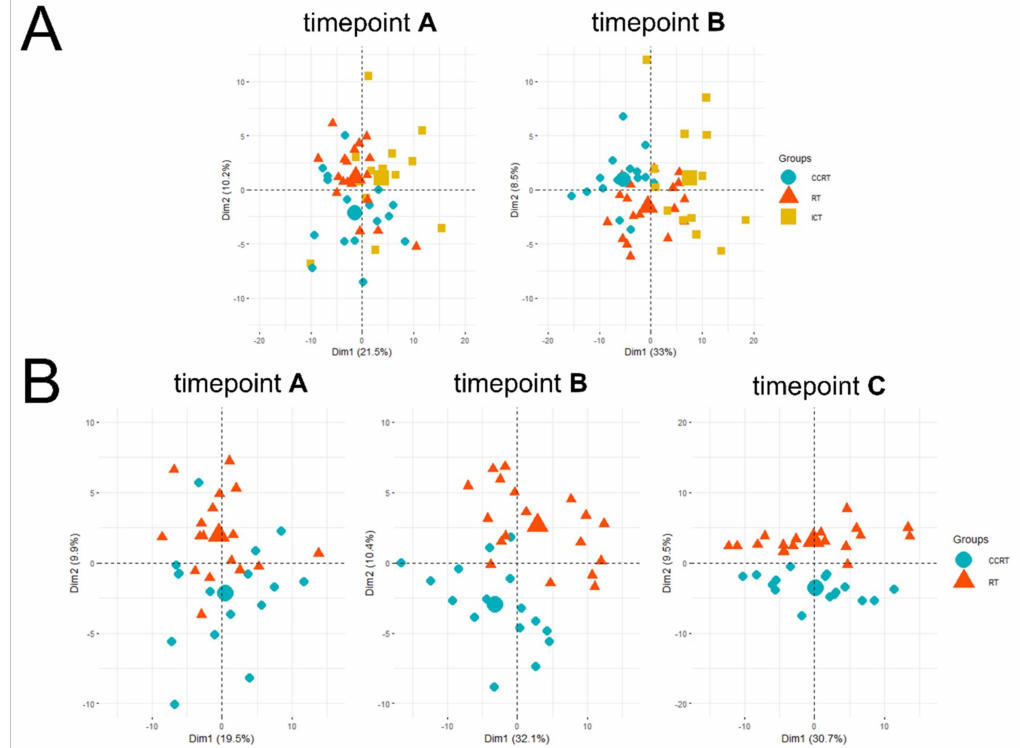
Figure 2. Principal component analysis (PCA) of the sample similarity. Panel ( A ) shows samples A and samples B collected in all three treatment modalities. Panel ( B ) shows three subsequent time points A, B, and C that correspond to samples collected before, during, and after the end of CCRT and RT treatments, respectively. Small marks denote individual patients, while bigger marks are the mean points of each treatment group. CCRT is labeled by blue dots, RT—orange triangles, and ICT—yellow